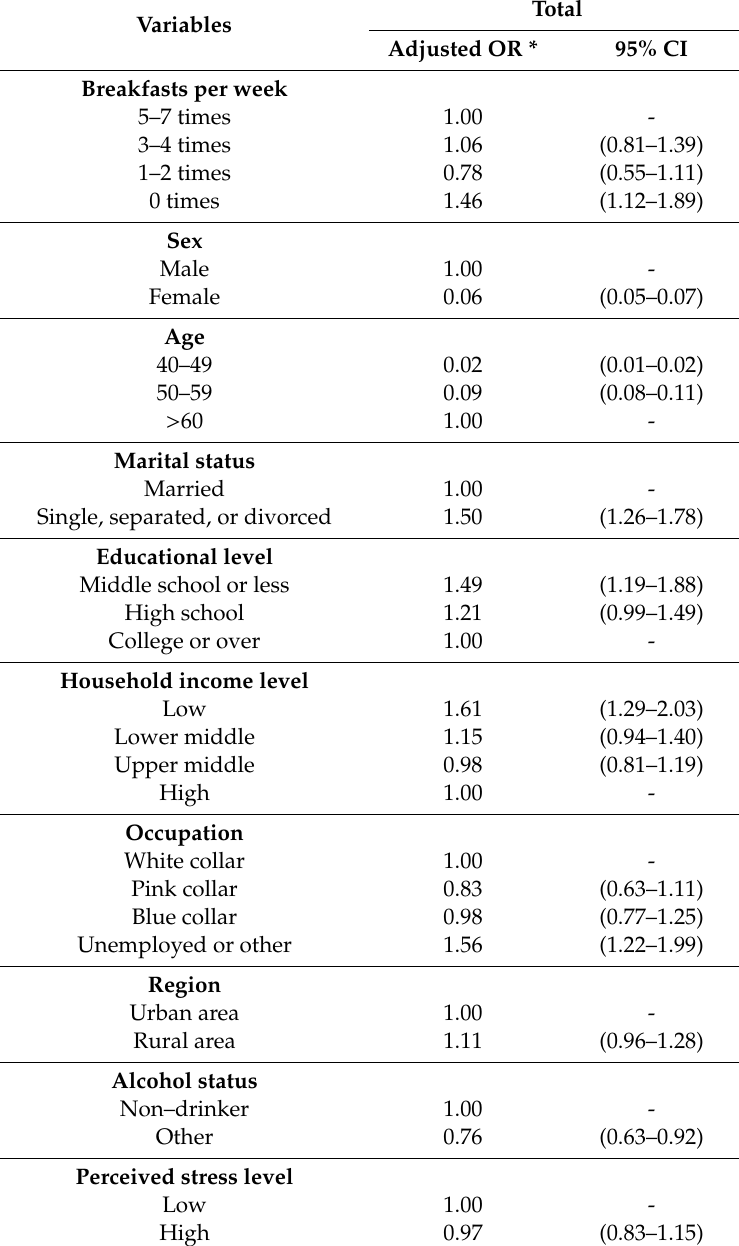
Table 2. Association between the number of breakfasts per week and high risk of